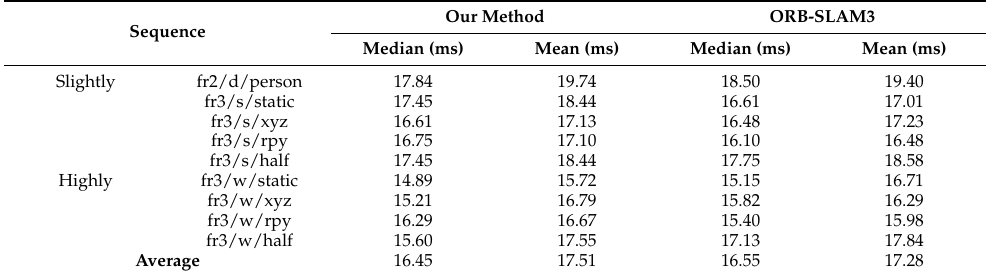
Table 6. Comparison of the real-time performance in dynamic environments.